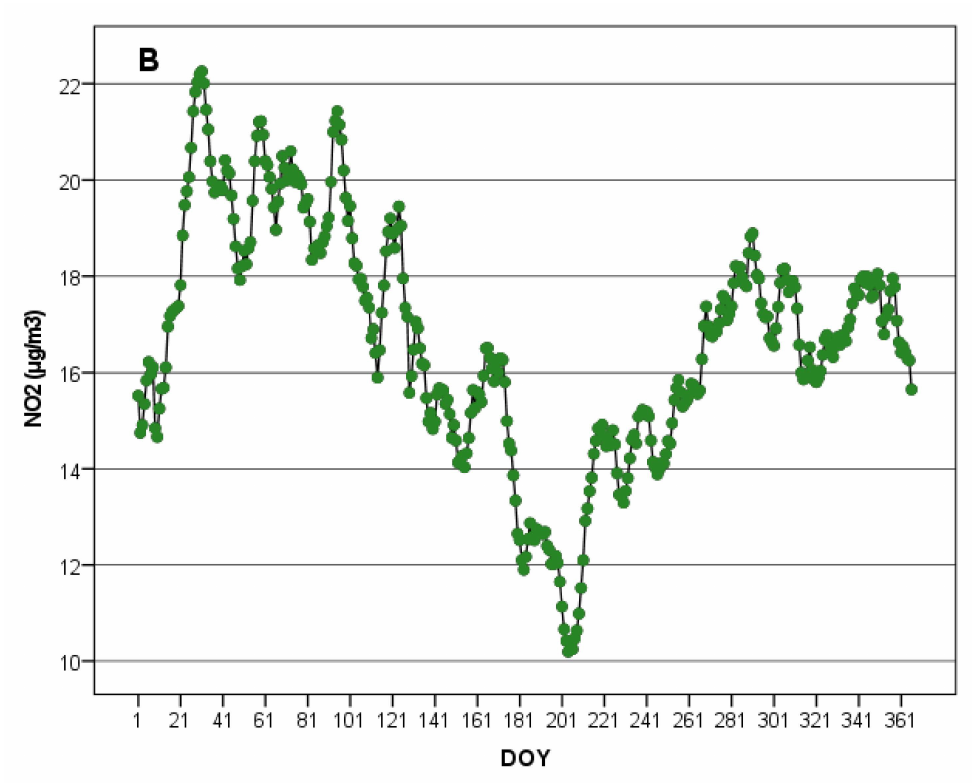
Figure 1. Seasonal dynamic of the 10-day average concentration of PM 10 ( A ) and NO 2 ( B ).